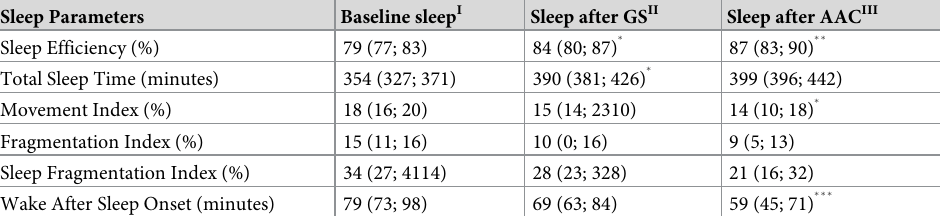
AAC, amino acid challenge; GS, glucose solution I Sleep measurements as an average of four nights; two nights before AAC day and two nights before GS. II Sleep measurements the night after GS day III